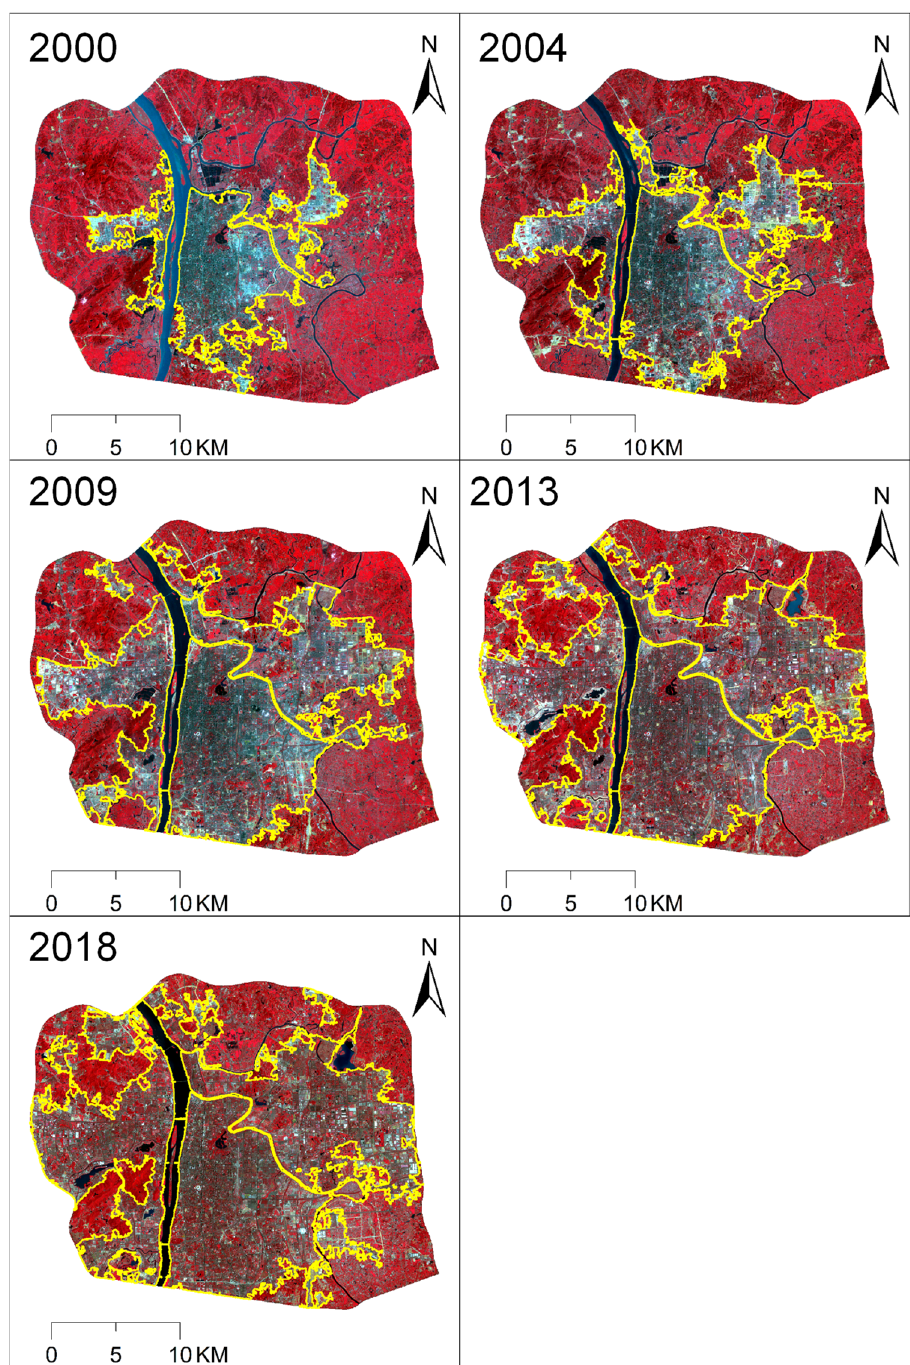
Figure 3. False color composite of Landsat images for selected years (the yellow lines indicate urban boundary). 163